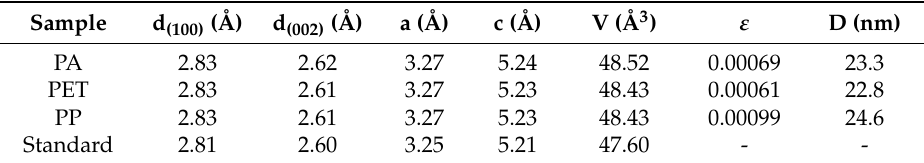
Table 4. Changes in ZnO unit cell parameters and crystallites.